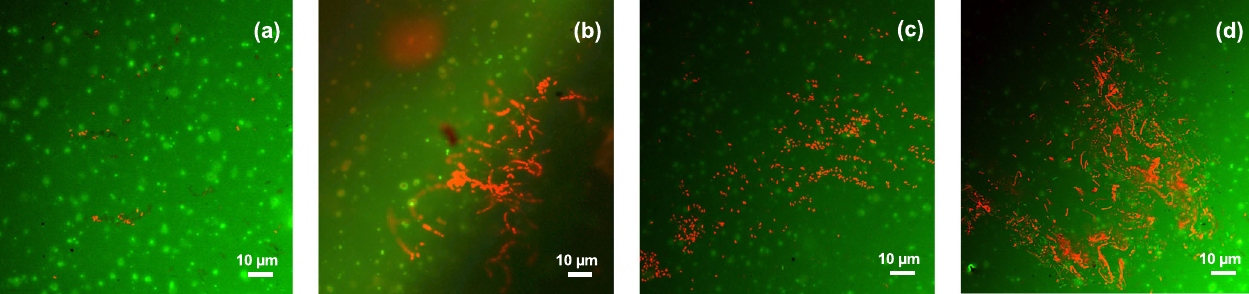
Fig. 7 LIVE/DEAD Bio fi lm imaging of polyurea coatings. a Pure_polyurea, with b un_TiO 2 , c 3%Ce-doped TiO 2 , and d 3%La-doped TiO 2 in E. coli CDC-reactor.